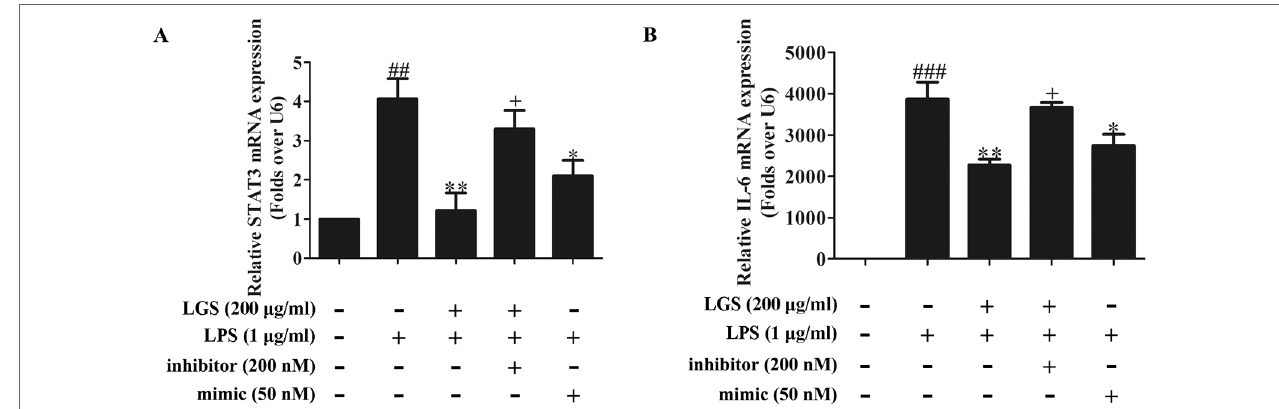
FIGURe 4 | The blockage of miR-21 abolishes the inhibitory effects of LGS on STAT3 mRNA (A) and IL-6 mRNA (B) . The cells were transfected with miR-21 mimic or inhibitor for 24 h. After transfection, macrophages were cultured with LGS (200 μg/ml) and LPS (1 μg/ml) for another 24 h. The mRNA expressions of STAT3 and IL-6 were measured by qPCR. Data are represented as the mean ± SEM of three independent experiments. ## P < 0.01 and ### P < 0.001 versus control, * P < 0.05, ** P < 0.01 versus LPS treatment, + P < 0.05 versus LGS treatment by one-way ANOVA with Tukey’s